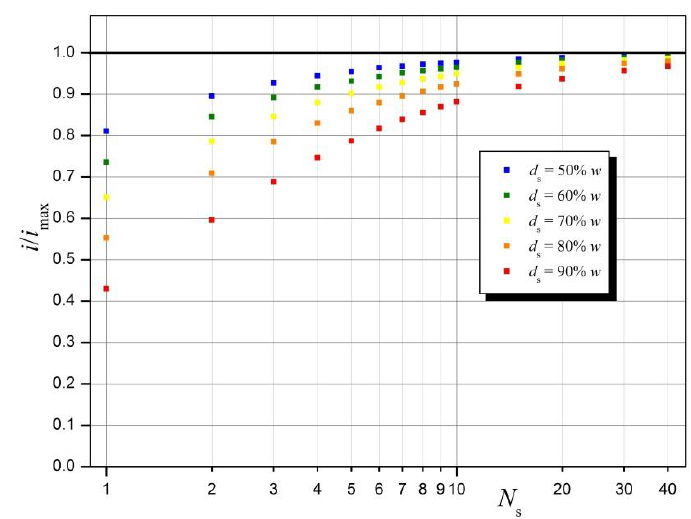
Figure 4. Results of calculations of the current intensity for different numbers of cracks N s and their different total lengths d s .